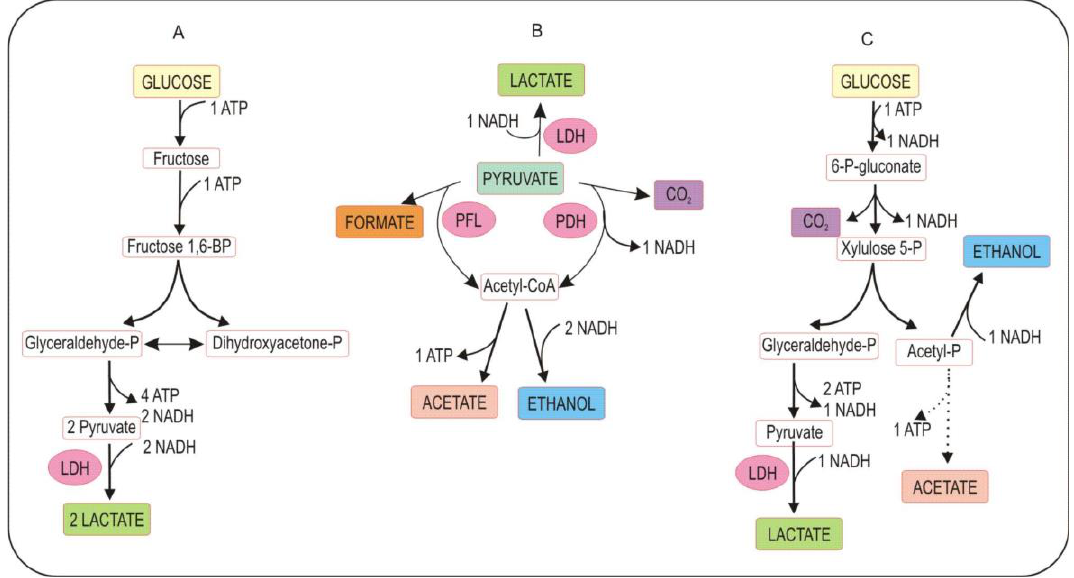
Figure 6. Catabolic pathways of glucose fermentation by lactic acid-producing bacteria (LAB). ( A ): homofermentation in Lactococcus lactis or Lactobacillus acidophilus , ( B ): mixed acid fermentation ( Lactococcus lactis ), and ( C ): heterofermentation in Lactobacillus casei . P: phosphate, BP: bisphosphate, PDH: pyruvate dehydrogenase, PFL: pyruvate formate lyase, and LDH: lactate dehydrogenase (Data from Johanson et al. (2020) [126] and Wang et al. (2021) [127].